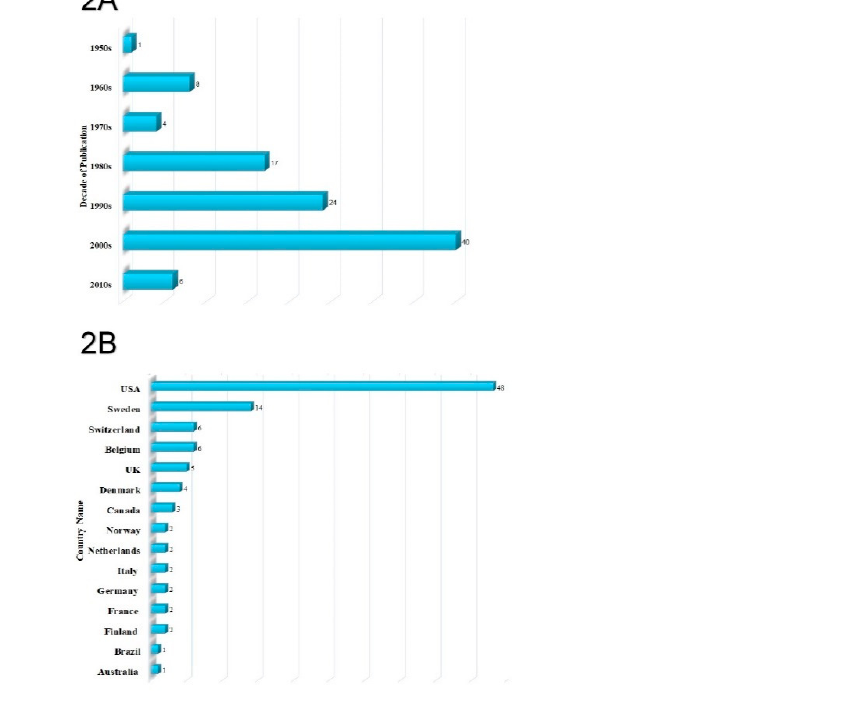
Figure 2. ( A ) Citation analysis of the top 100 most-cited articles over the decades. ( B ) The contribution of countries to the top 100 articles.